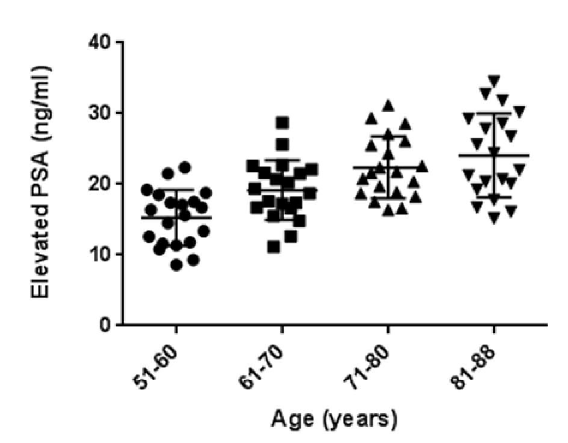
Figure 3. The elevated PSA value in different age group of patients The blood samples of patients of the respective age groups were assayed for PSA level. The elevated PSA value in the different patients of all age group. (The data of 20 samples of each group is